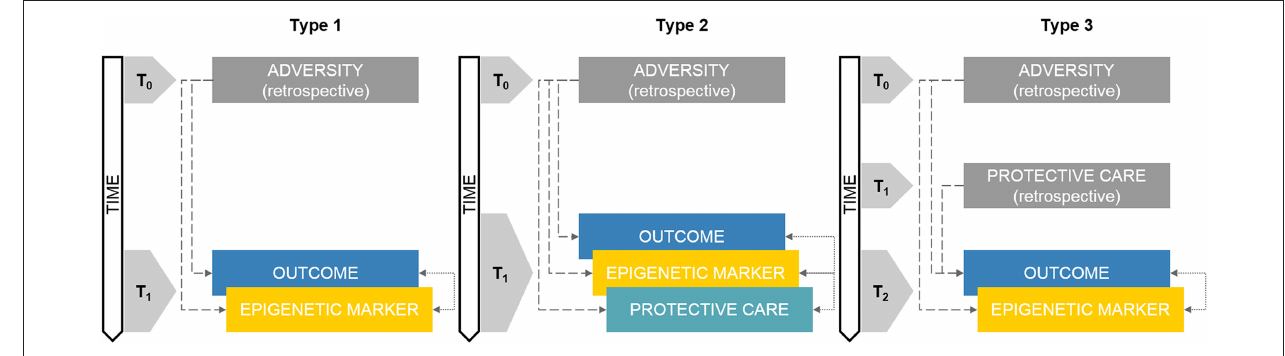
FIGURE 1 | Schematic representations of retrospective developmental human behavioral epigenetics (DHBE) study designs. Note. Type 1: concurrent assessment of epigenetics and outcomes; Type 2: concurrent assessment of epigenetics, care exposures and outcomes assessment; Type 3: retrospective exposure to adversity/care and concurrent assessment of epigenetics and outcomes. Gray boxes reflect retrospective measurements. Double-headed arrows reflect correlational nature of the association. Colored boxes reflect non-retrospective assessments. The annotation t n refers to progressive time-points in the research study